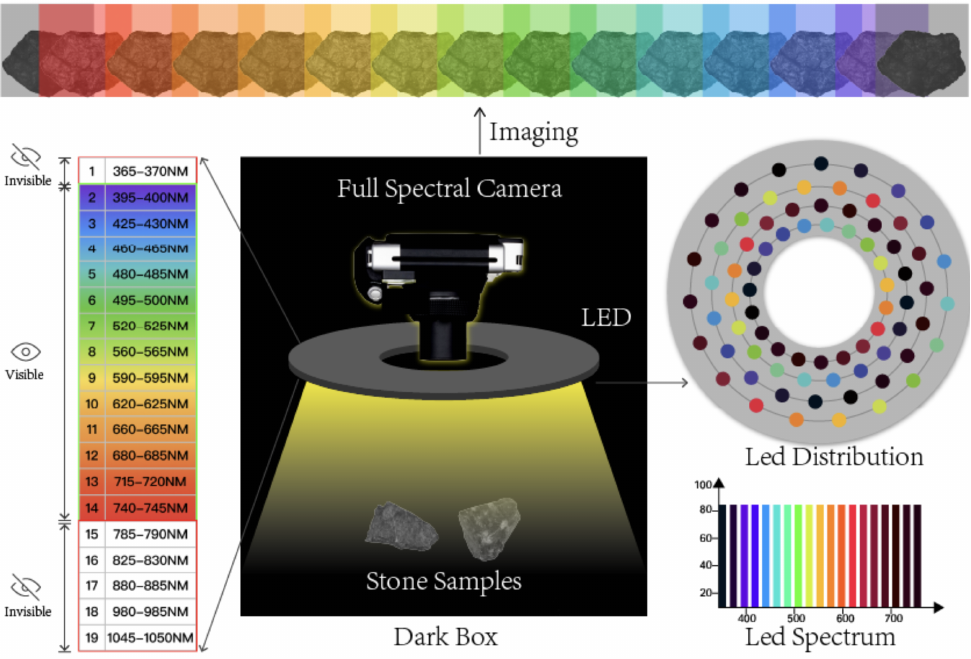
Figure 2. Active hyperspectral imaging system prototype. An overview of the proposed active hyperspectral imaging system (prototype version) collecting images in a low-light/dark